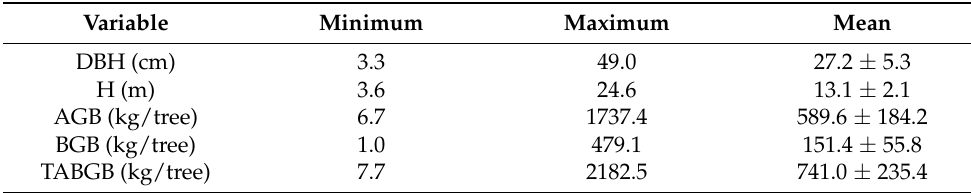
Table 5. Characteristics of the 10 sample trees for